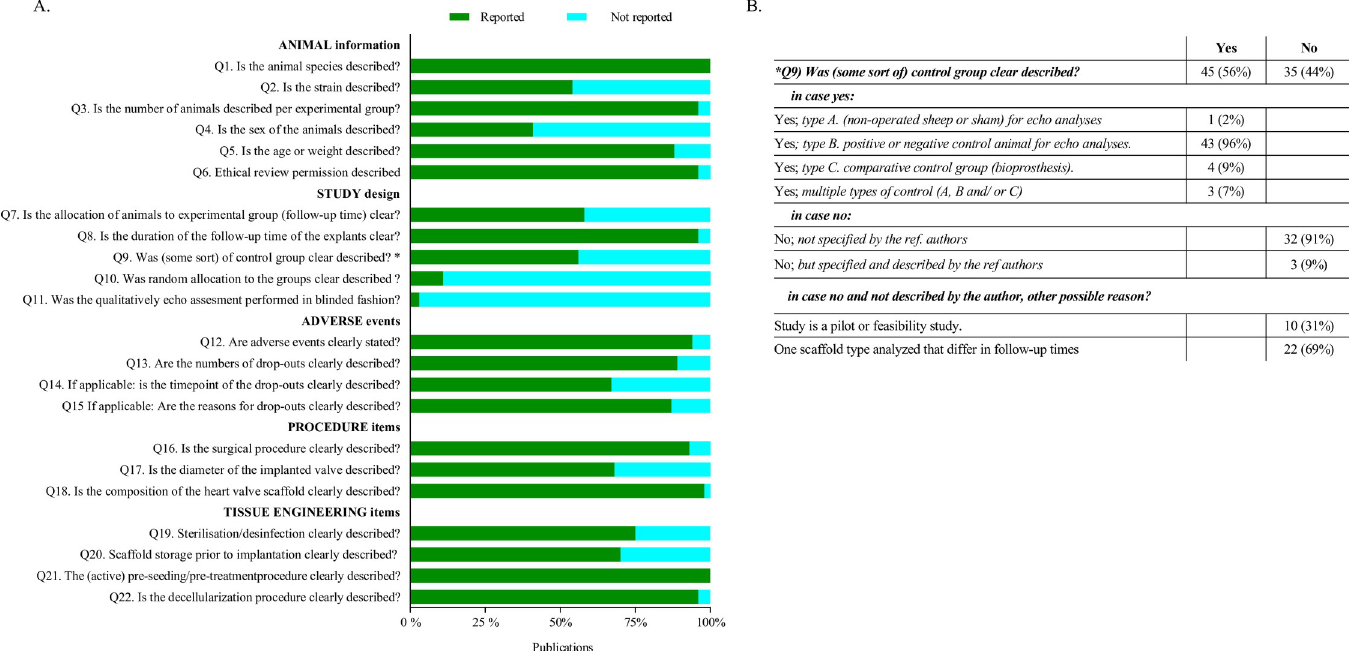
Fig 5. Quality assessment of included articles (total n = 80). (A) Quality of reporting on animal information, study design, adverse events, procedure items, and specific tissue engineering items showed a general moderate report of all items except the random allocation to the groups (selection bias) and blinding of the assessment of echo quality (detection bias). (B) Specification of the control variants showed a general preference for the use of a positive or negative control if a control was used. The absence of control groups consisted mainly of an unspecified description by the referenced authors, but these studies usually only showed results for one subgroup.